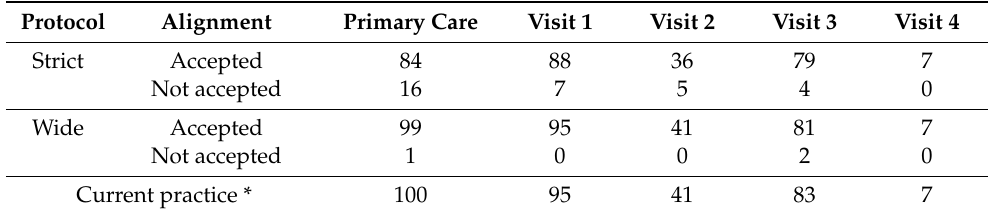
Table 5. Fracture alignment after primary care and during follow-up visits No